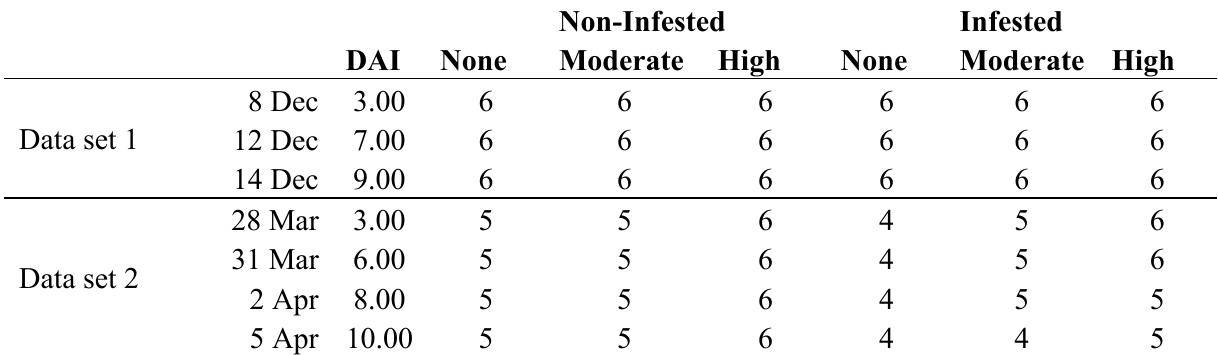
Table 1. Data sets (total of 229 hyperspectral images) included in this